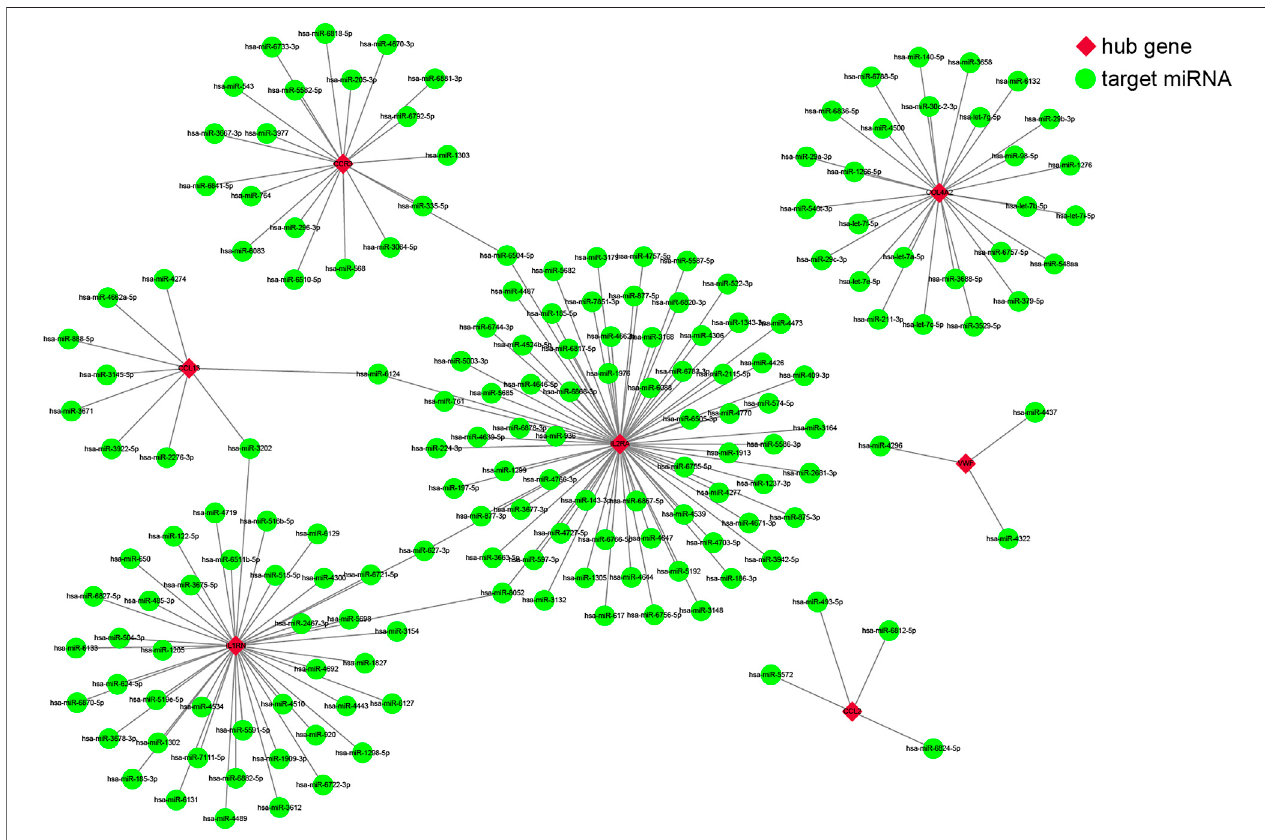
FIGURE 4 | The co-expressed network of messenger RNAs (mRNAs) and target microRNAs (miRNAs). The mRNA-miRNA co-expressed network was constructed by Cytoscape, including 180 nodes and 178 edges. Red diamonds represent the hub genes, and green circles represent miRNAs.